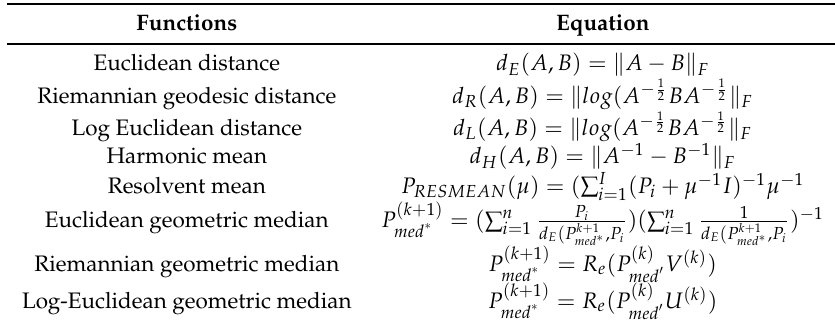
Table 1. The different functions for calculating the centrality of covariance